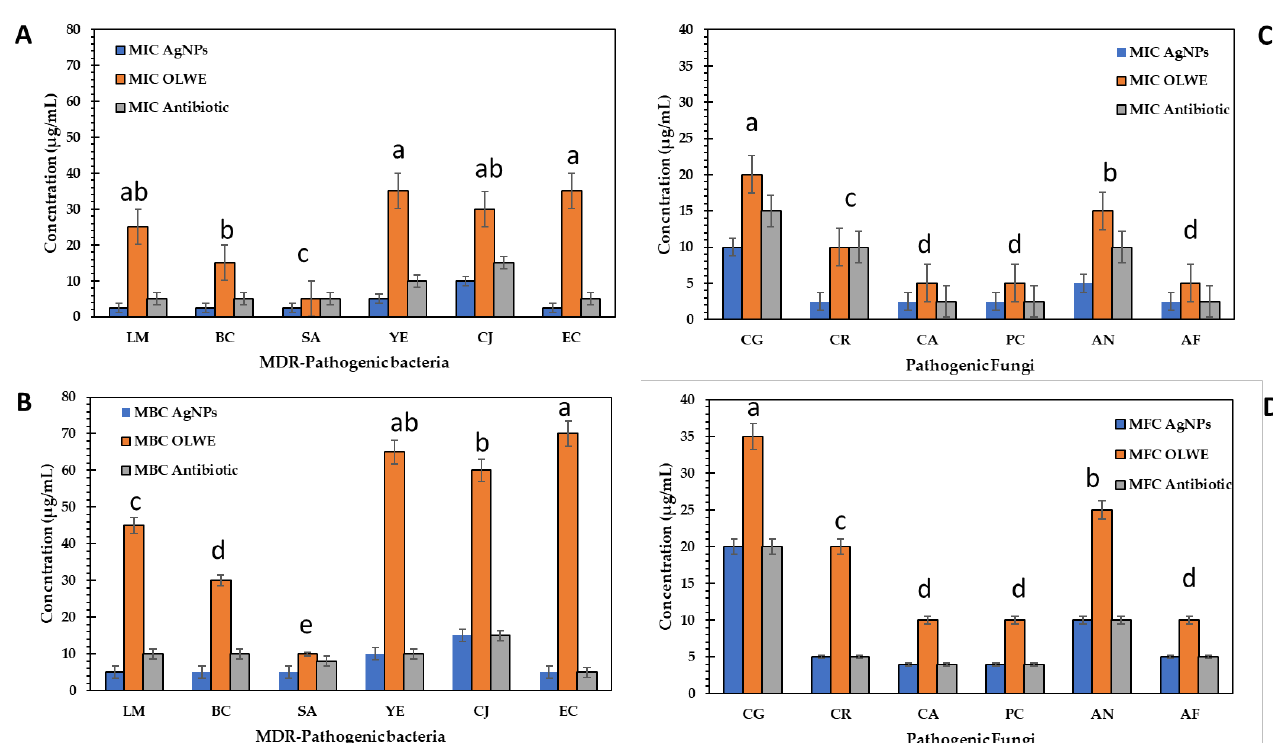
Figure 6. MIC, MBC, MFC of AgNPs, OLWE, and antibiotics against MDR pathogenic bacteria and fungi causing various diseases. Lowercase letters above columns indicate significant differences at the 5% probability level.